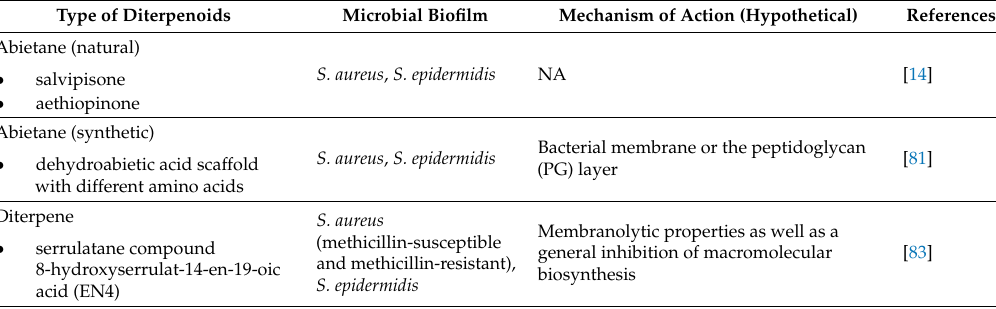
Table 6. Examples of diterpenoids with anti-biofilm